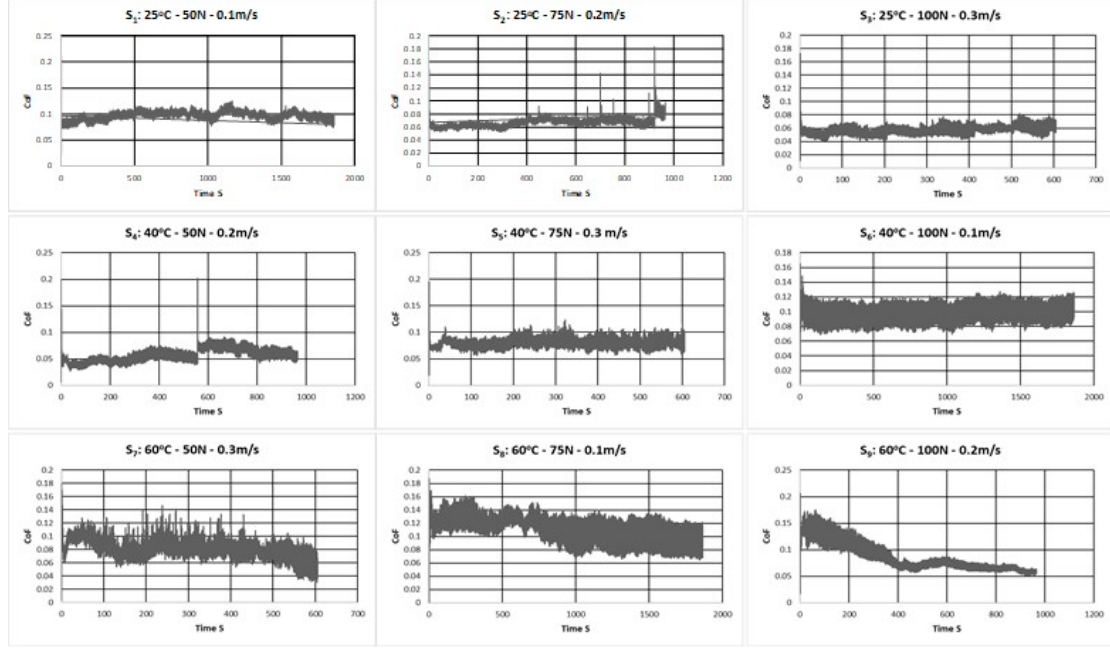
Figure 5. Typical frictional graphs corresponding to the different runs of the L9 array of the Taguchi Design.